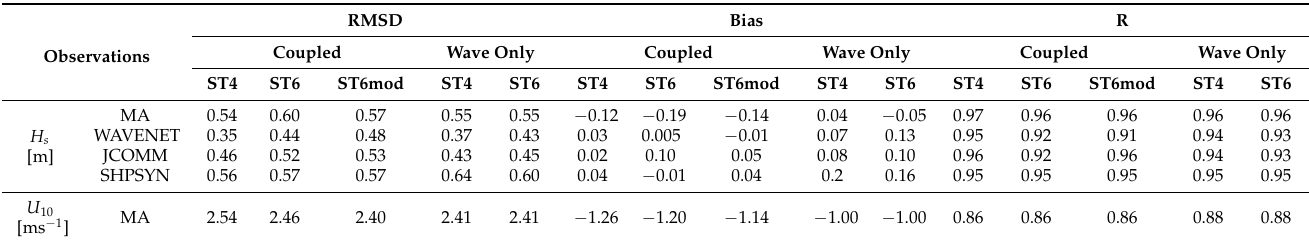
Table 4. Summary statistics (root-mean-square deviation (RMSD), bias and correlation coefficient (R) for significant wave height ( H s ) and wind speed ( U 10 ): UKC4aow-ST4, UKC4aow-ST6, UKC4aow-ST6mod, UKW4h-ST4 and UKW4h-ST6 versus observations of merged altimeter (MA), JCOMM, SHPSYN and WAVENET (coastal observations) over 2013-11-30 to